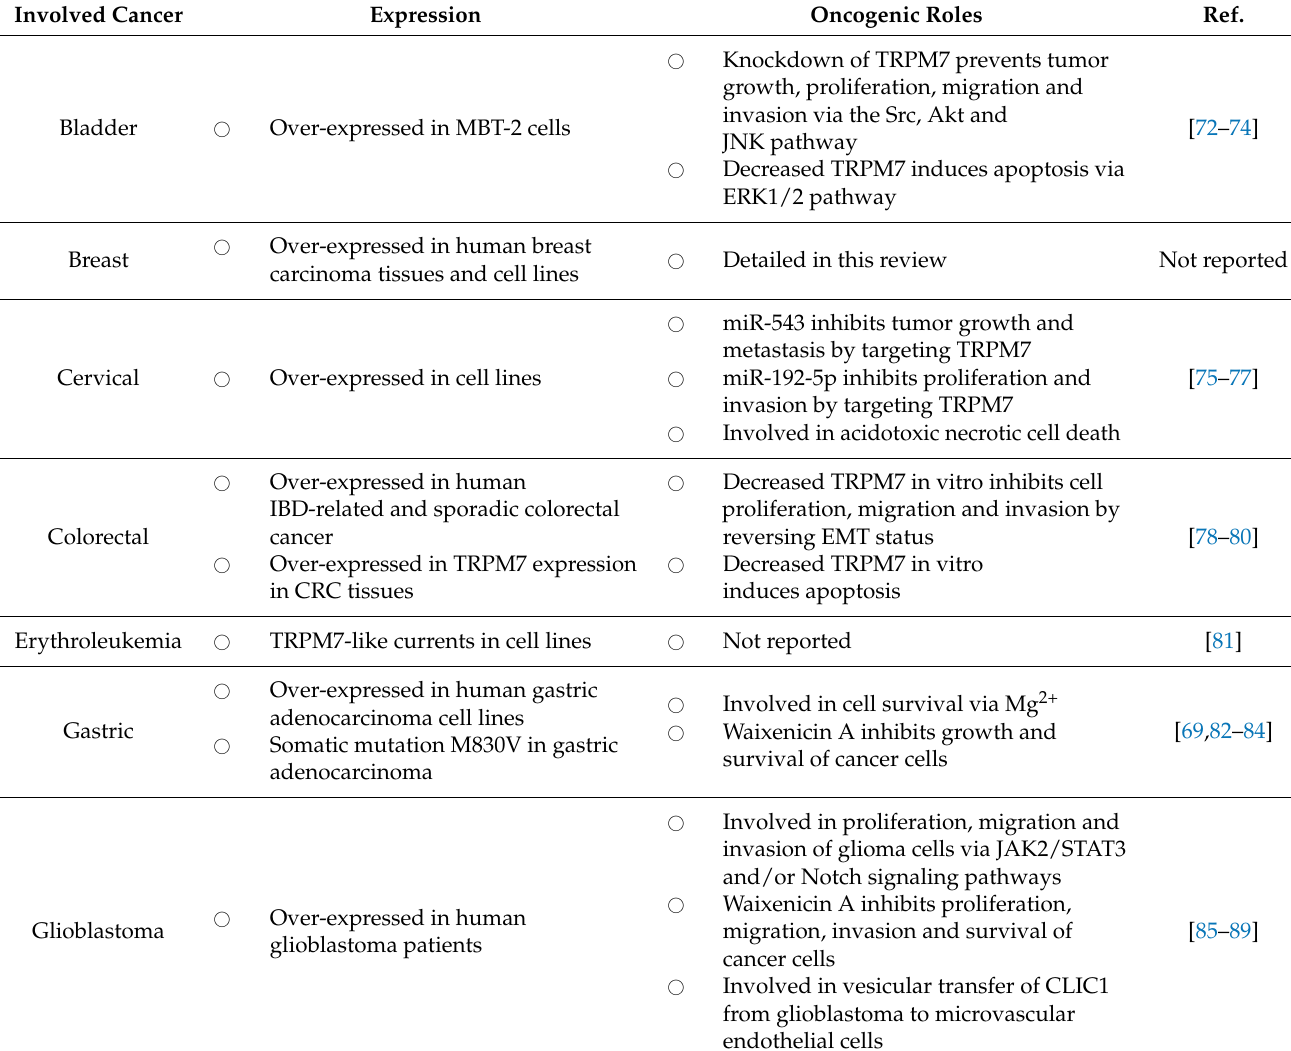
Table 1. Expression and oncogenic roles of TRPM7 in cancers. Involved Cancer Expression Oncogenic Roles